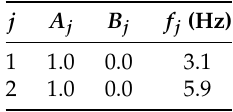
Table 2. Parameters used to generate simulated signal.